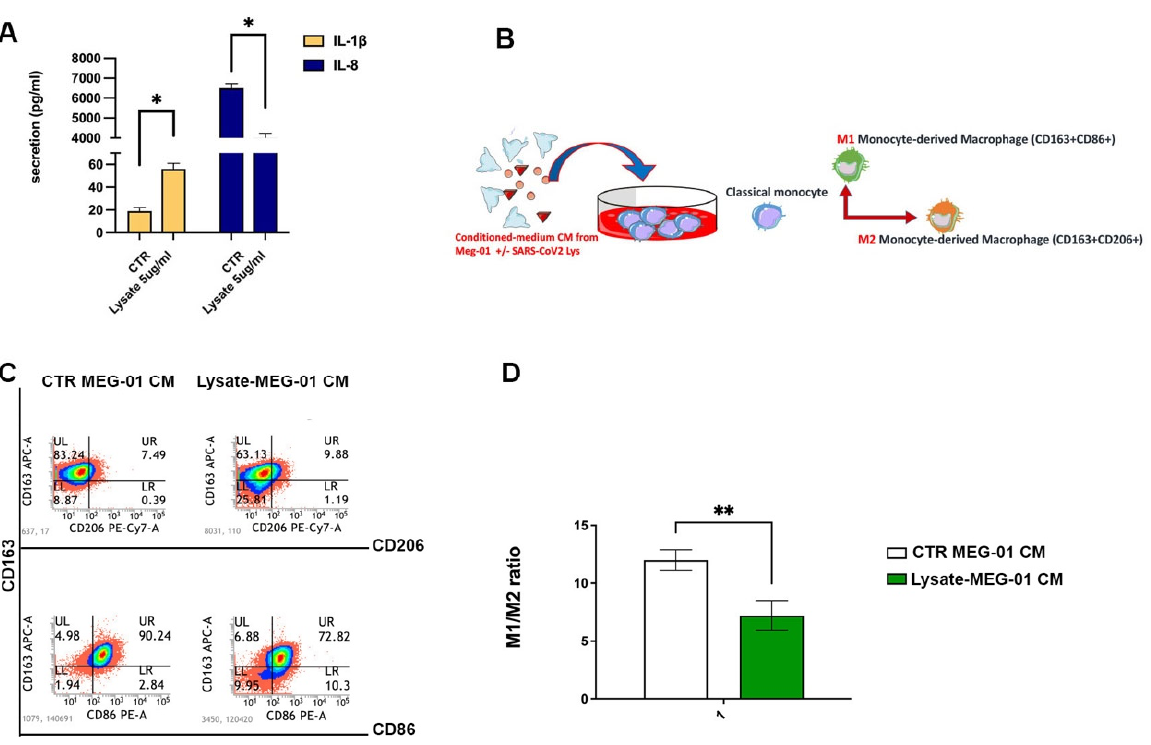
Figure 4. SARS ‐ CoV ‐ 2 lysate affects platelet ‐ like particles/MEG ‐ 01 secretome and M1/M2 ratio. ( A ) Histogram shows IL ‐ 1 β and IL ‐ 8 secretion levels (pg/mL) in conditioned media of undifferentiated MEG ‐ 01 exposed to inactivated SARS ‐ CoV ‐ 2 (5 μ g/mL) or control lysate for 24 h and detected by multiplex ELISA. Pairwise comparisons are reported (ordinary one ‐ way ANOVA; * p < 0.05). The results are representative of three independent experiments expressed as mean ± SD. ( B ) Graphical diagram summarizing the steps of the applied protocol. Conditioned media from undifferentiated MEG ‐ 01 exposed or not exposed to inactivated SARS ‐ CoV ‐ 2 (5 μ g/mL) lysate were added to classical monocytes obtained from donors’ whole blood to induce M1 and M2 ‐ like macrophages. After 7 days, macrophages were harvested and characterized through flow cytometry. M1 ‐ monocyte ‐ derived macrophages are CD163/CD86 double ‐ positive cells, while M2 ‐ monocyte ‐ derived macrophages are CD163/CD206 double ‐ positive cells. ( C , D ) Representative FACS dot plots displaying the abundance of different macrophage subsets based on the expression of CD163, CD86, and CD206 markers expressed at the cell surface of recovered macrophage upon 7 days of conditioning with supernatant from MEG ‐ 01 exposed or not exposed to inactivated SARS ‐ CoV ‐ 2 (5 μ g/mL) lysate. Relative mean fluorescence intensity (MFI) ± SD of three independent experiments is shown as the M1/M2 (CD163+CD86+/CD163+CD206+) ratio ( D ). A pairwise comparison is reported (one ‐ way ANOVA, ** p < 0.01).